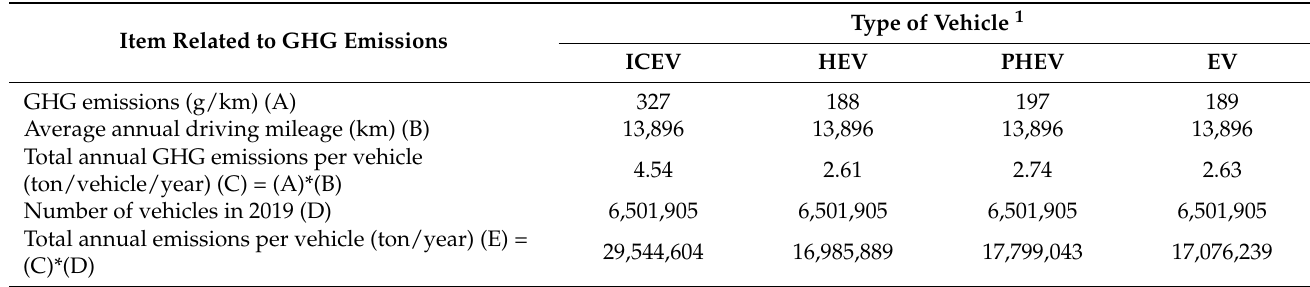
Table 7. Annual GHG emissions for each type of vehicle.